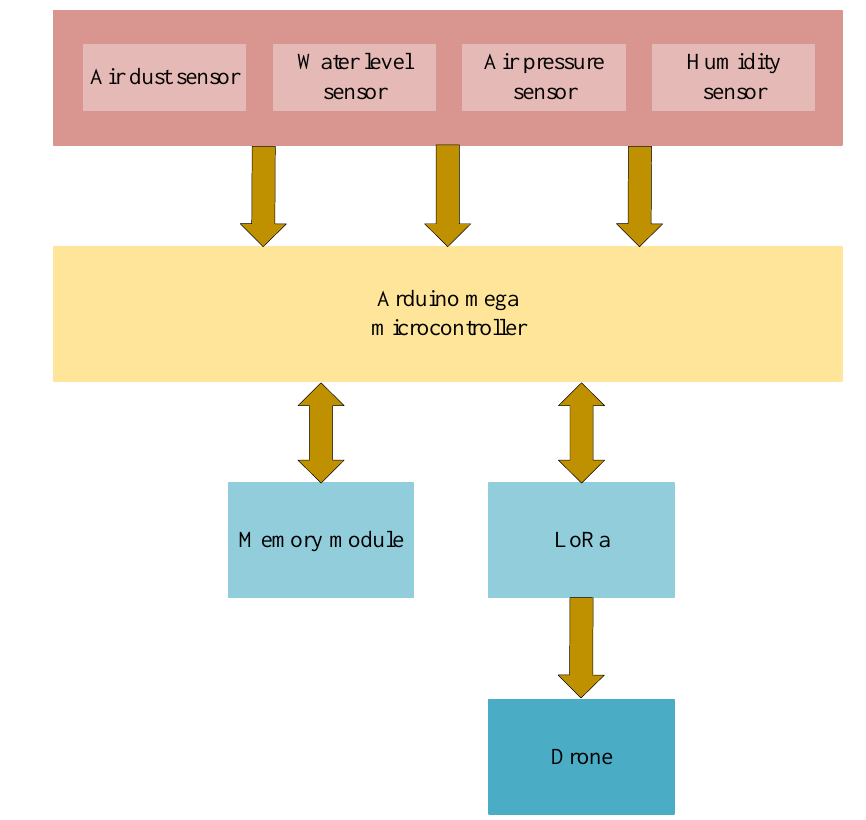
Figure 4. The structure of this natural environment monitoring device